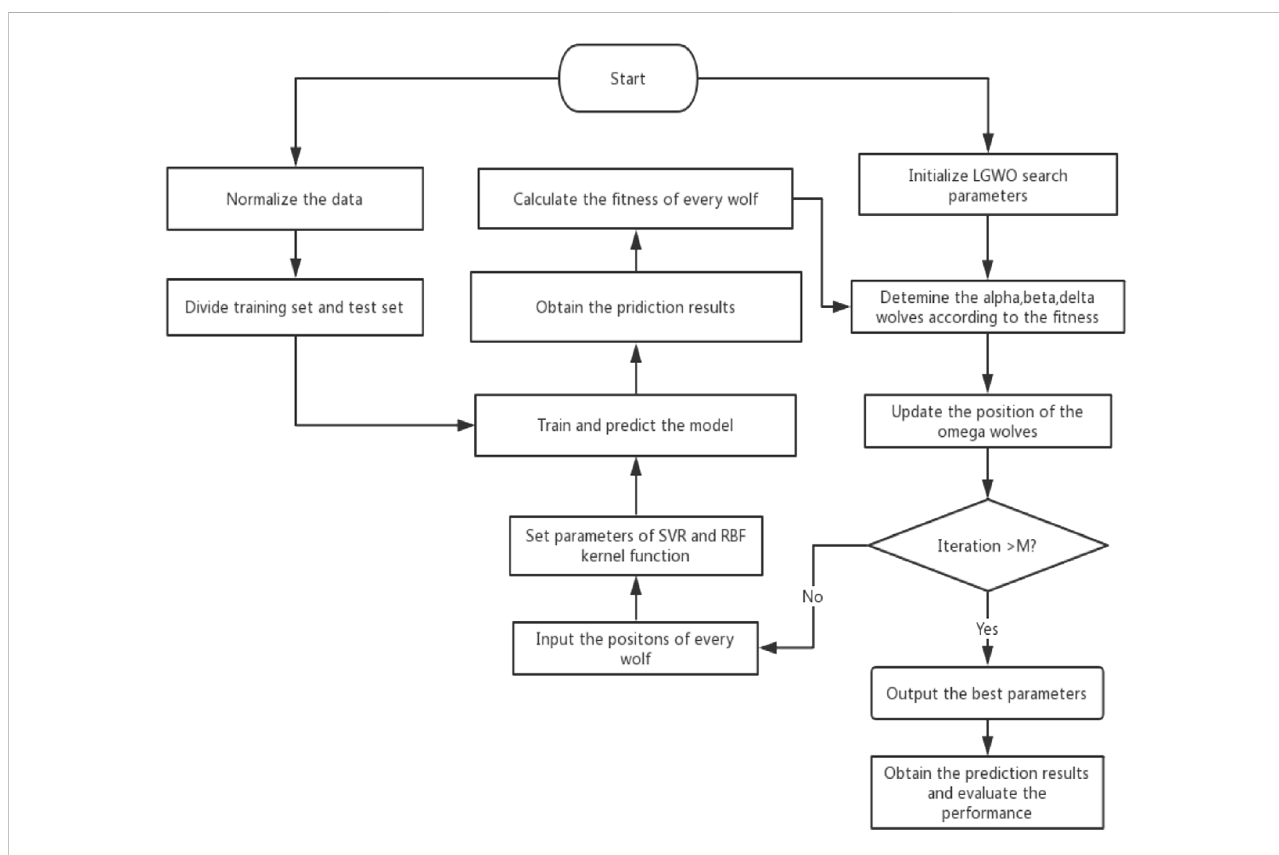
FIGURE 5 Structure of the proposed LGWO-SVR